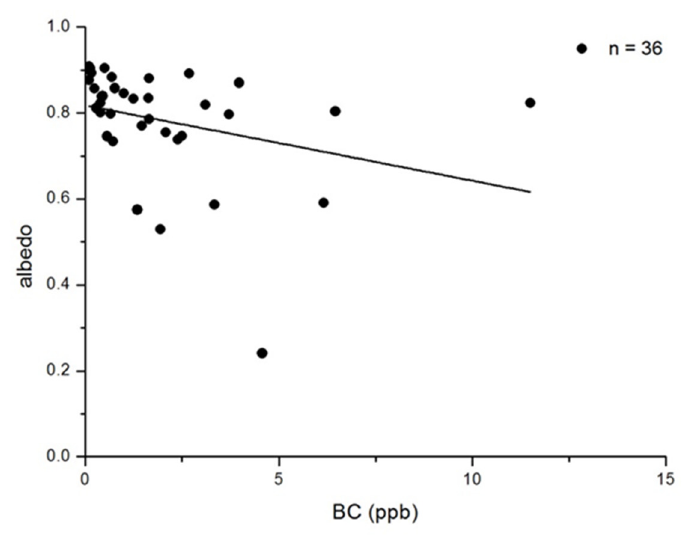
Figure 7. Relationship between BC concentrations and albedo of the QT No. 1 Glacier in 2015.